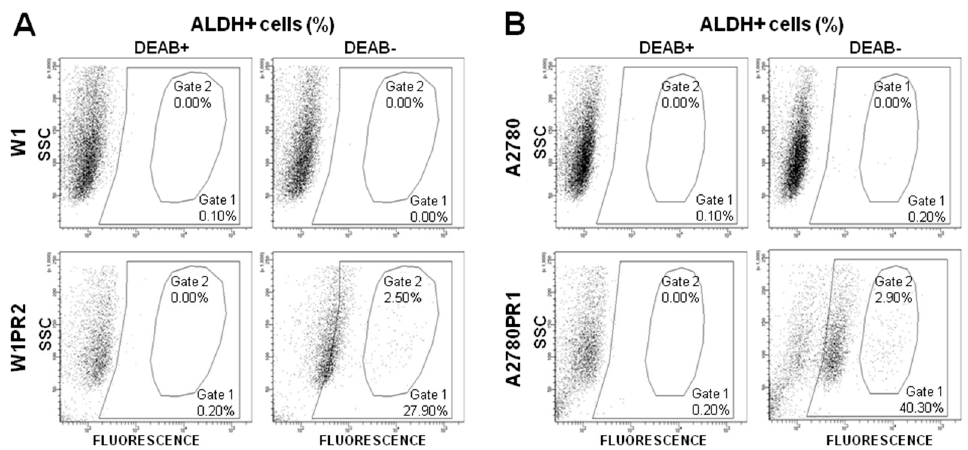
Figure 4. Flow cytometry analysis of ALDH+ cell content in W1 and W1PR2 ( A ) as well as in A2780 and A2780PR1 cell lines ( B ) DEAB, a specific inhibitor of ALDH, was used for confirmation of gating areas. Fluorescence was measured using a fluorescein isothiocyanate (FITC) channel.